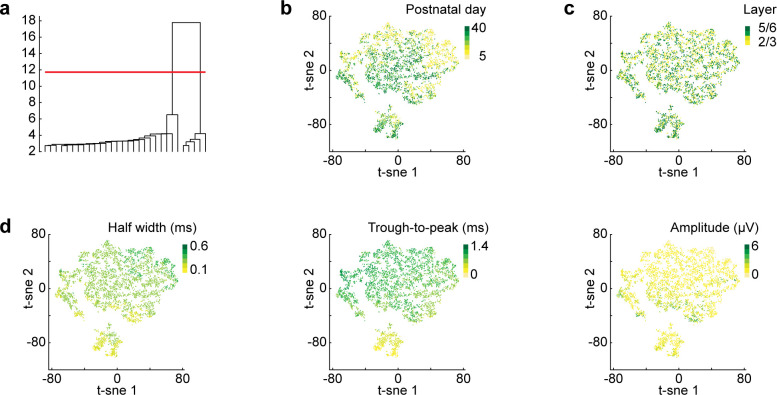
t-sne dimensionality reduction.(a) Dendrogram of binary hierarchical clustering after t-sne dimensionality reduction. The height of the lines represents the distance between subclusters. (b) Scatter plot showing the first two components of a t-sne dimensionality reduction on the mean waveforms for all units recorded from P5-40 (n = 3554 units from 66 recordings/mice) color coded by age. (c) Same as (b) color coded by mPFC layer. (d) Same as (b) color coded by values of classic spike shape features (half width, trough to peak time, amplitude).Figure 2—figure supplement 1—source data 1.Source data for Figure 2—figure supplement 1b–d.